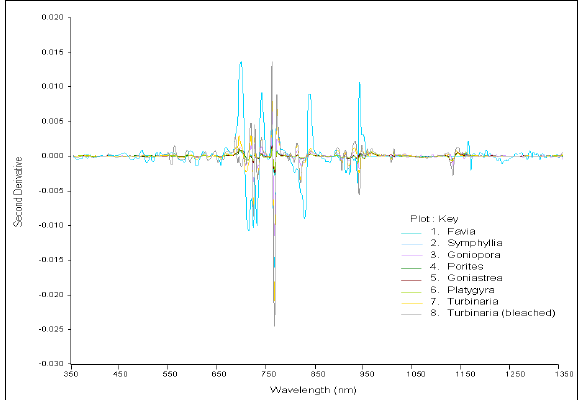
Figure 7. Second derivatives of the sampled coral